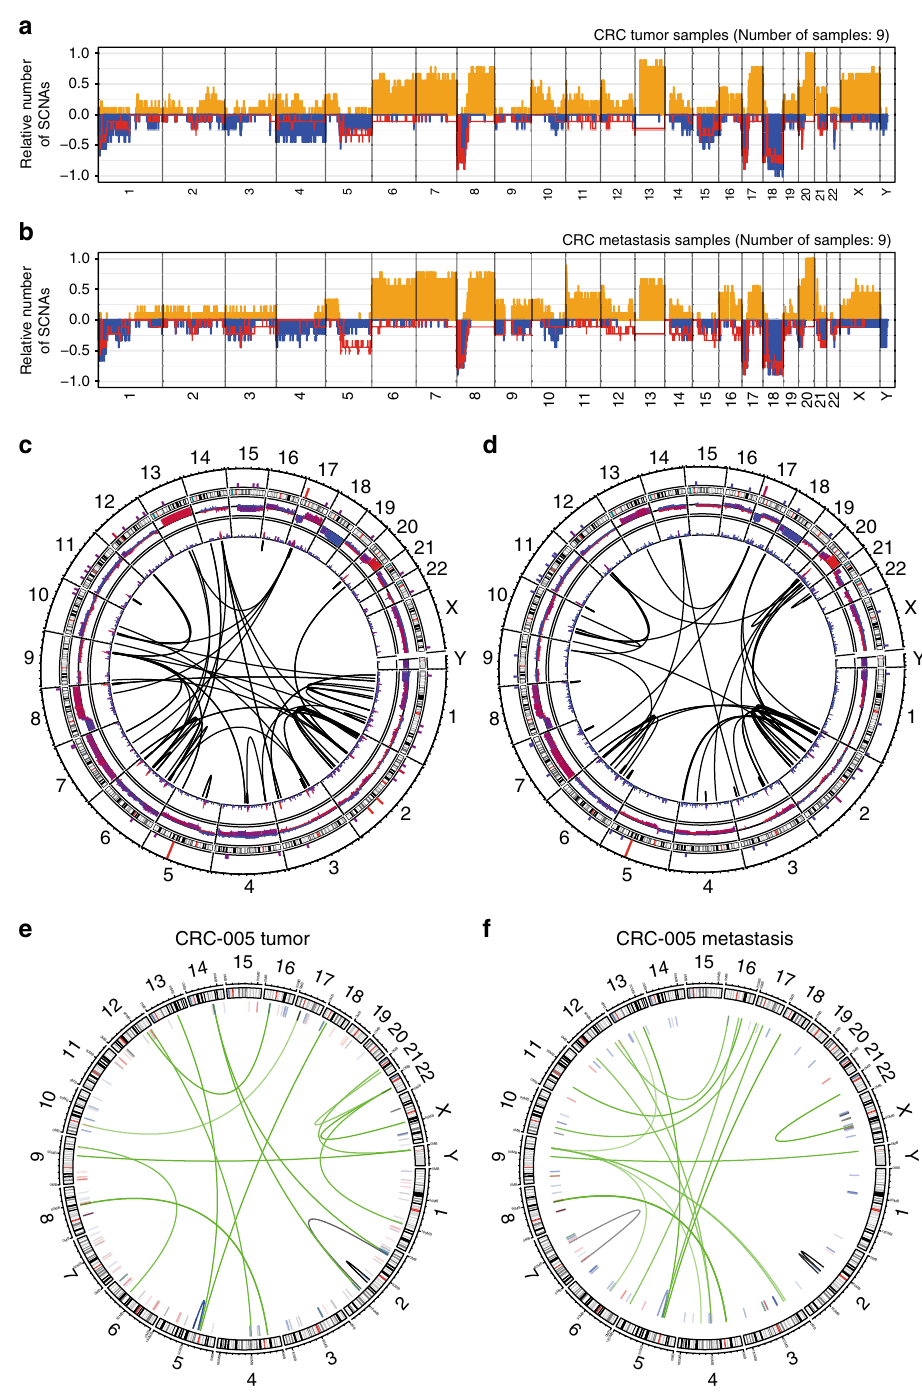
Fig. 2 Recurrent somatic copy number aberrations and structural variations. Relative prevalence of somatic copy number aberrations (predicted by ACEseq) in high tumor cell content (TCC) primary tumors a and metastasis b samples, showing presence of at least one copy number gain (orange bars), copy number loss (blue bars), and LOH (red line) as a proportion of analyzed samples. Circular plots of recurrent (minimum of 3) somatic structural variations (SVs) in high TCC tumors c and metastasis d samples. The panels (from outside going inwards) represent small somatic variant recurrence per gene, genomic cytobands, copy number changes (predicted by SOPHIA), and recurrent SVs within TAD regions. As an example of SV heterogeneity, we show the SV landscape for CRC-005 tumor e and metastasis f . Arcs represent translocation and inversion